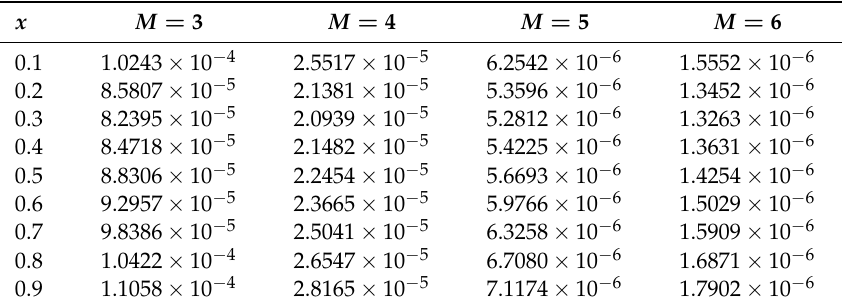
Figure 1. The absolute errors of Example 1 for quasilinearized semi-orthogonal B-spline wavelet method (QSOBWM) with M = 3,4,5,6. Table 1. Absolute errors of QSOBWM of Example 1.